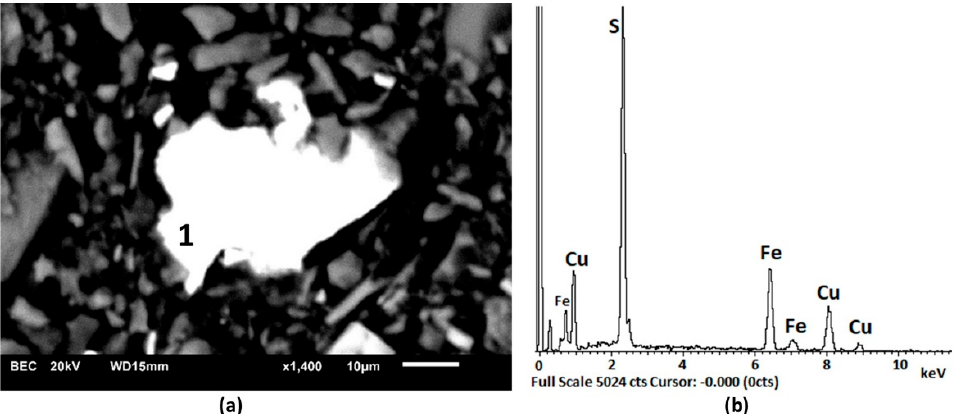
Figure 10. SEM image ( a ) and EDS analysis ( b ) of Zone 1. Unreacted chalcopyrite (1) in the products of the pretreatment of copper sulphide ore with 15 kg/t of H 2 SO 4 , 25 kg/t NaCl, and 15 days of curing at room temperature. In ( a ), the image is at a magnification of ×1,400.